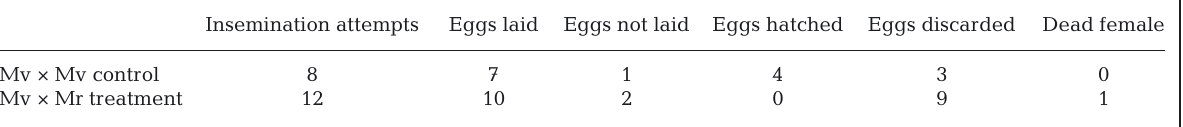
Fig. 4. Cross-species encounters and cannibal- ism of post pre-mating molt (PMM) receptive females. (A) A receptive Macrobrachium vol- lenhovenii female (white arrow) being canni- balized by another female, while the M. rosen- bergii male (seen at the back) is not guarding the receptive female. The exuvia can be seen in the top left corner of the image (white cir- cle). (B) M. rosenbergii male cannibalizing a post PMM receptive M. vollenhovenii female. The exuvia can be seen at the top of the image (white circle). Bar represents 4 cm